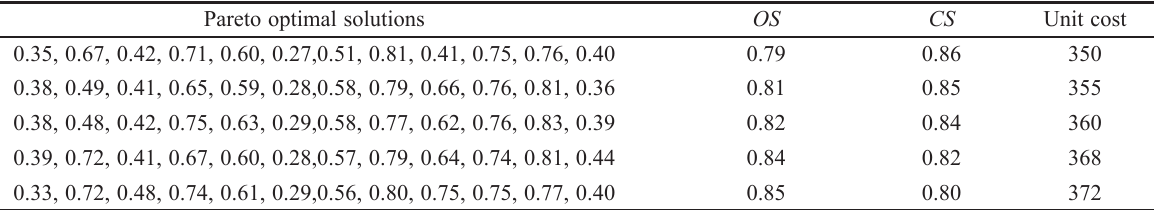
Table 3. Sample Pareto optimal solutions Pareto optimal solutions OS